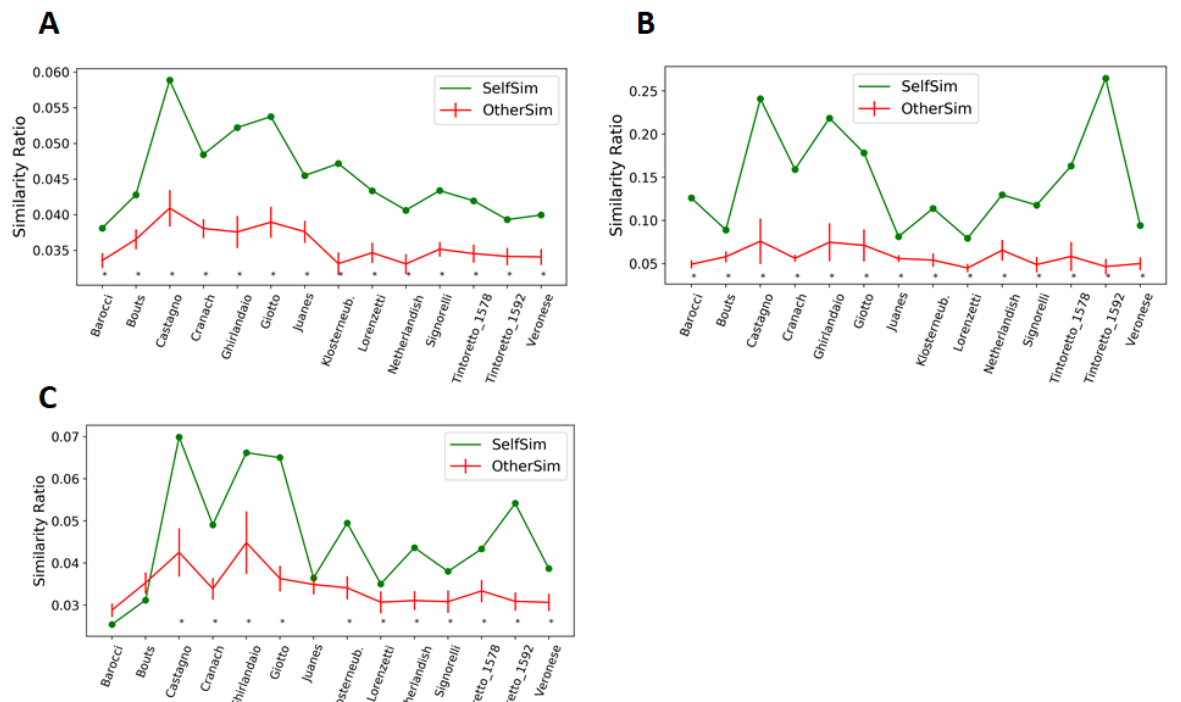
Fig 3. All measures are sensitive. A) Saccade Variability: for each painting the similarity ratio of saccades to saccades from the same painting is shown in green and is always significantly above the average similarity from other paintings (red). B) Drawing Variability: the similarity ratio of drawings to drawings from the same painting (green) is significantly above the average similarity to drawings from other paintings (red). C) Saccade-Drawing Similarity: the similarity ratio of saccades to drawings from the same painting (green) for most paintings is significantly above the similarity ratio comparing those saccades to drawings from other paint- ings (red), thereby demonstrating a relationship between the shape of the saccades and the drawn composition lines. These figures are based on 9*9 divisions grid. (Error bars: SEM, * p <.01, one-sample